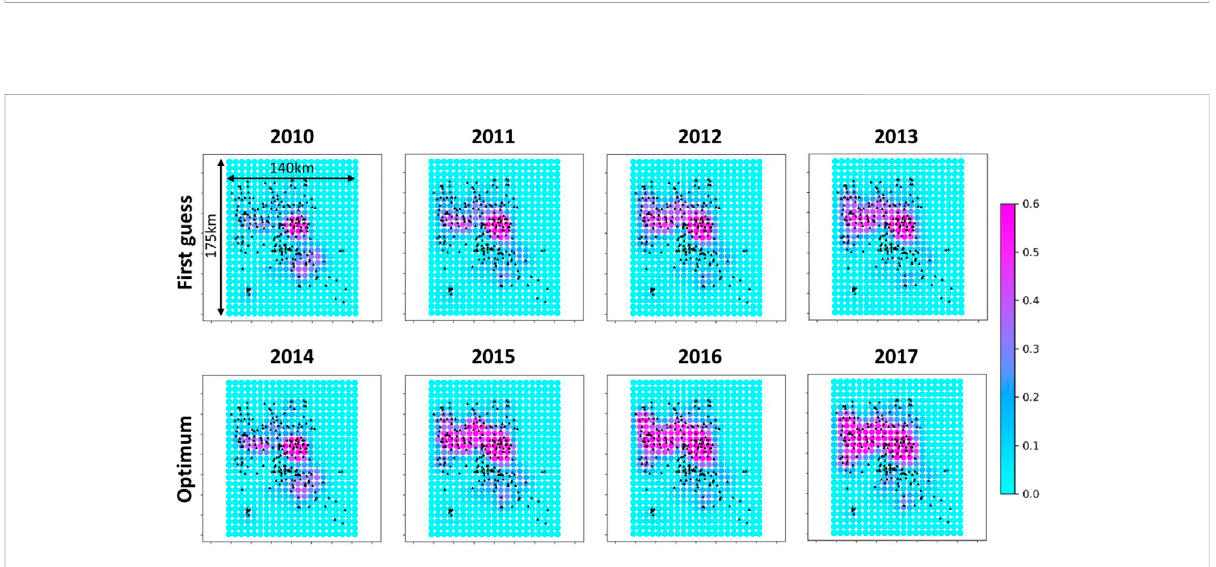
Comparison of the total injected volumes (m 3 ) per wells. Note the range difference of each color scale in the bottom maps.